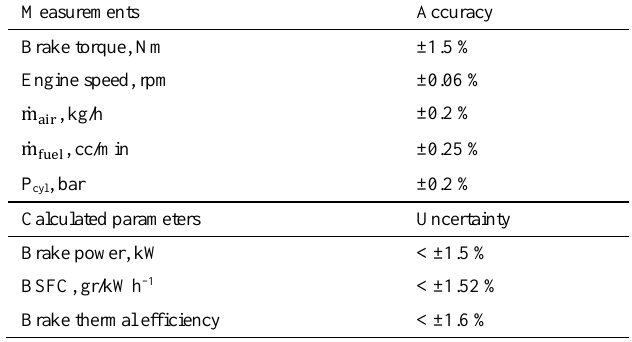
T ABLE 4. M EASURED AND C ALCULATED U NCERTAINTIES IN E